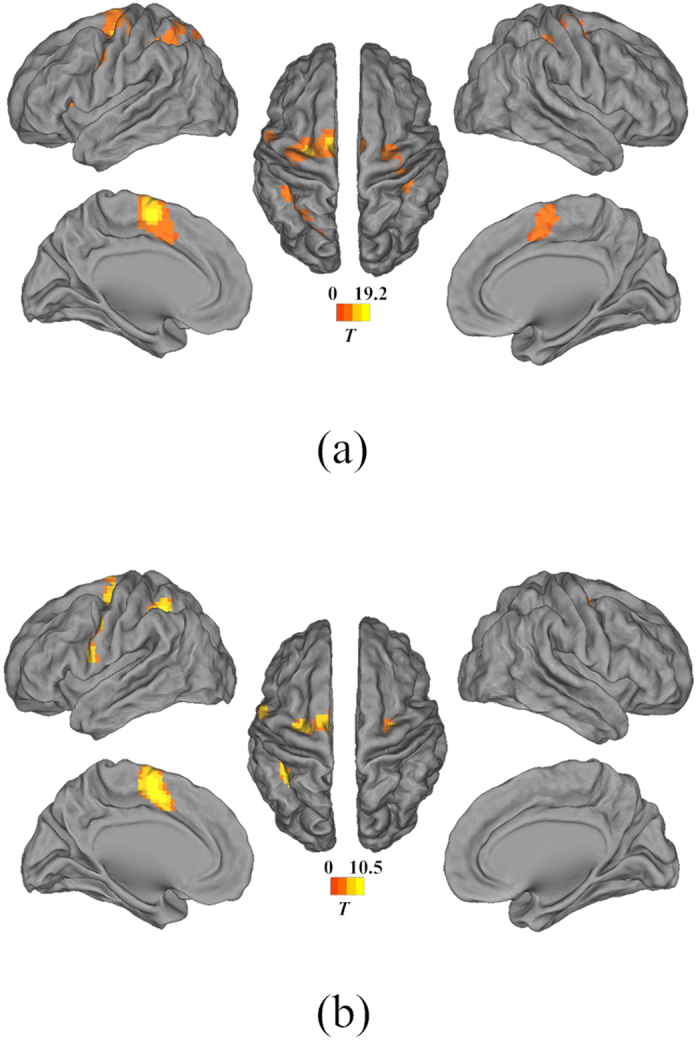
Activation maps for the different single-hand MI tasks.The statistical parametric maps of group data thresholded at p < 0.001 (T > 4.587) and the degree of freedom df = 10. (a) The activated regions during the left-hand MI. (b) The activated regions during the right-hand MI.